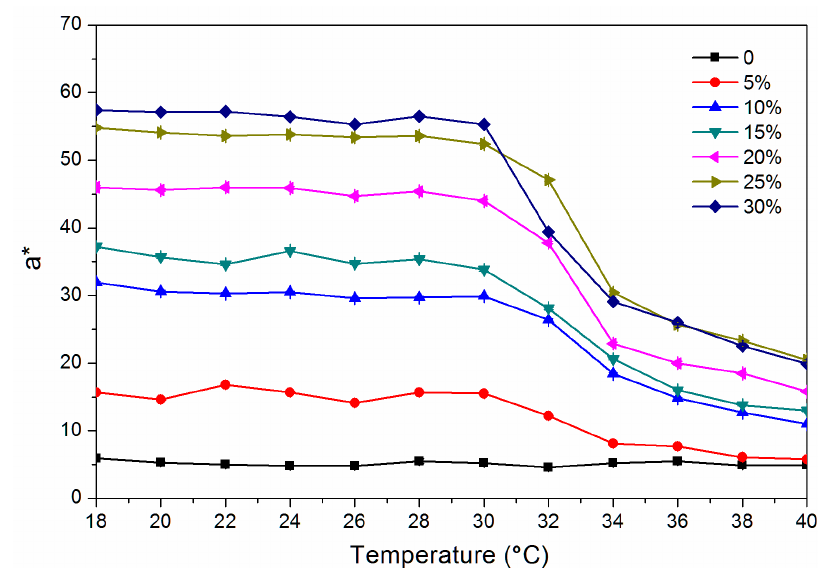
Figure 2. Change of a* value from 18 to 40 ° C.